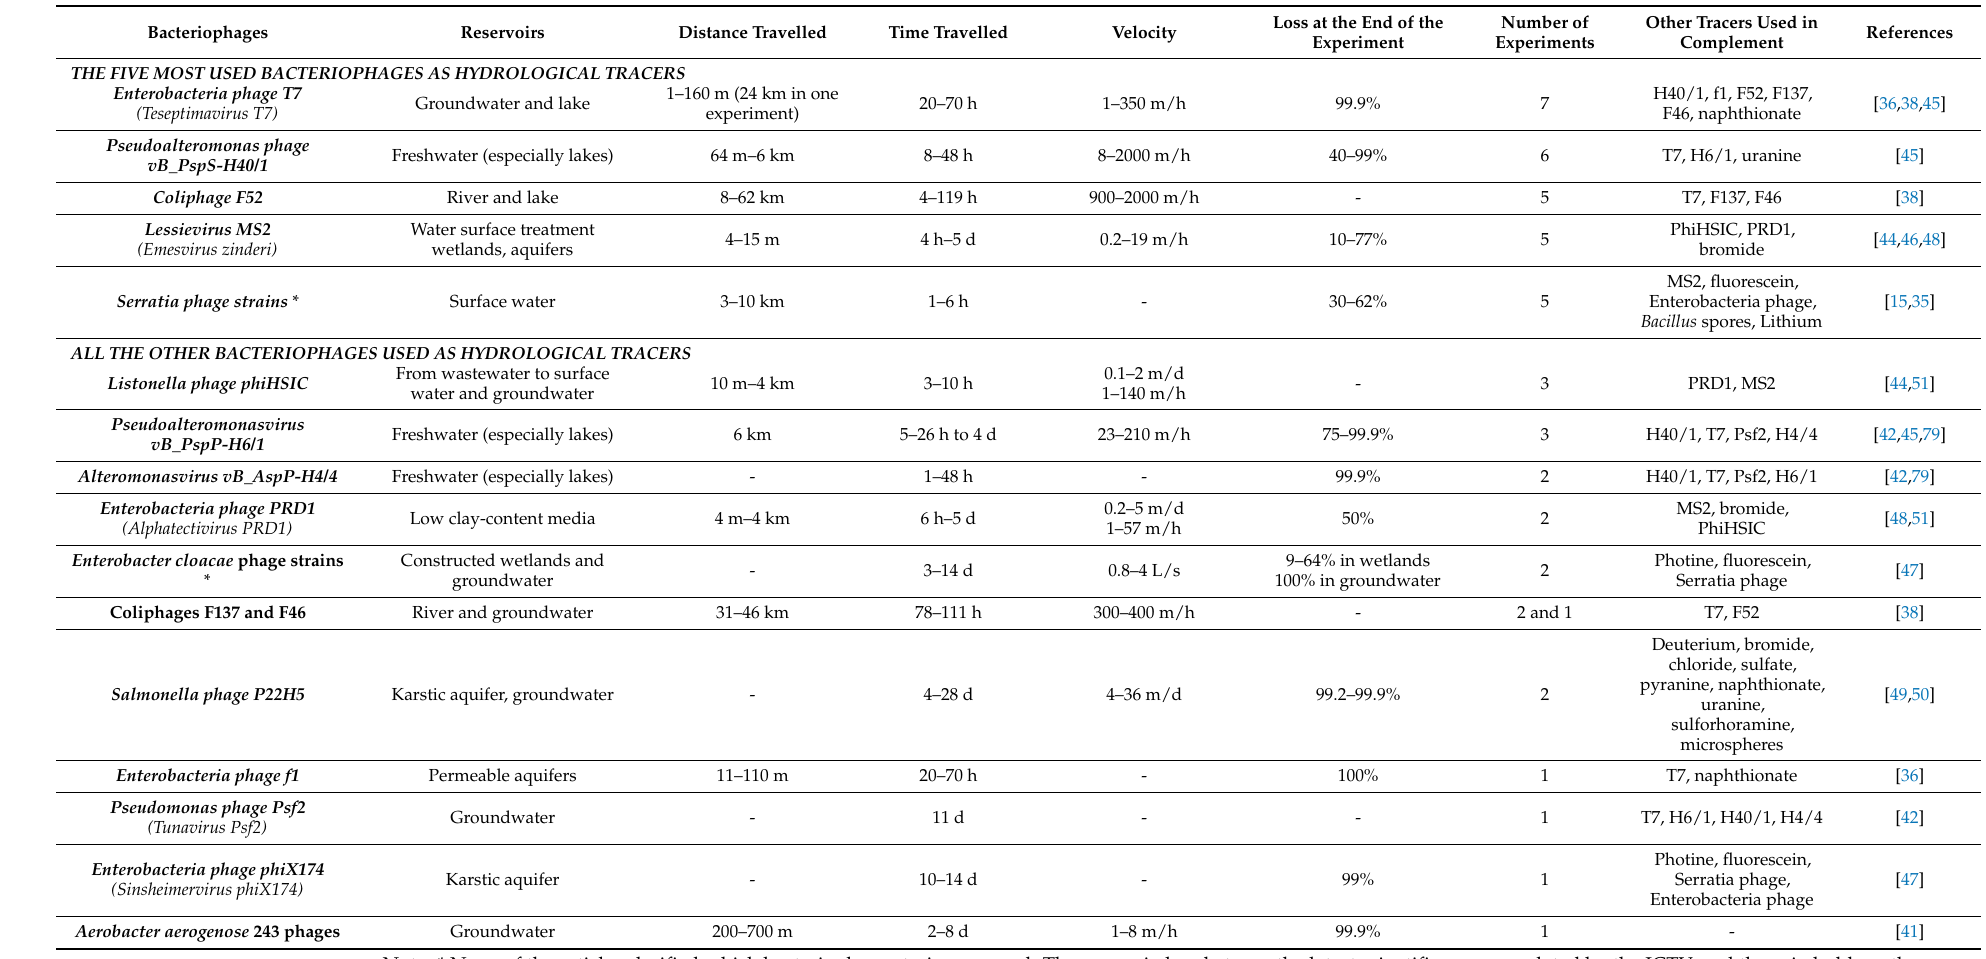
Table 2. Characteristics of the transportation of bacteriophages during the various tracing